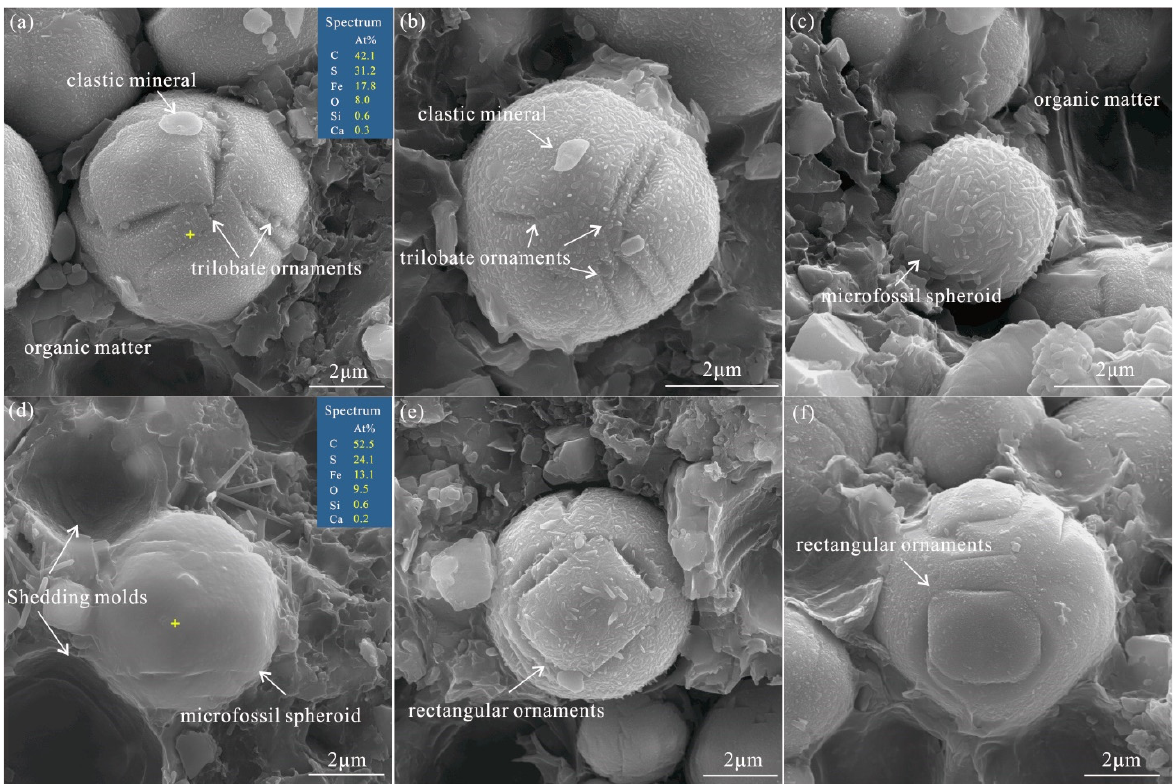
Figure 6. Microscopic photographs of individual Microcystis (all bars represent 2 µ m). ( a , b ) Individ- uals with trilobate ornaments on the cell surfaces are attached by clastic minerals and encircled by organic matter. ( c ) Microfossil spheroid encircled by organic matter. ( d ) Microfossil spheroid and shedding molds. ( e , f ) Microfossil spheroids with rectangular ornaments on the cell